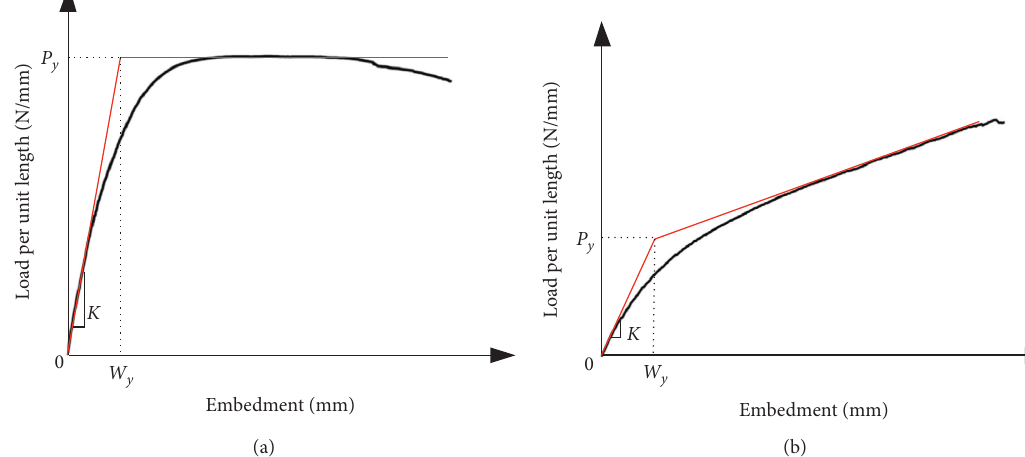
Figure 1: Load-embedment curves obtained from embedment tests and corresponding bilinear relationships. (a) Parallel to grain. (b) Perpendicular to grain.